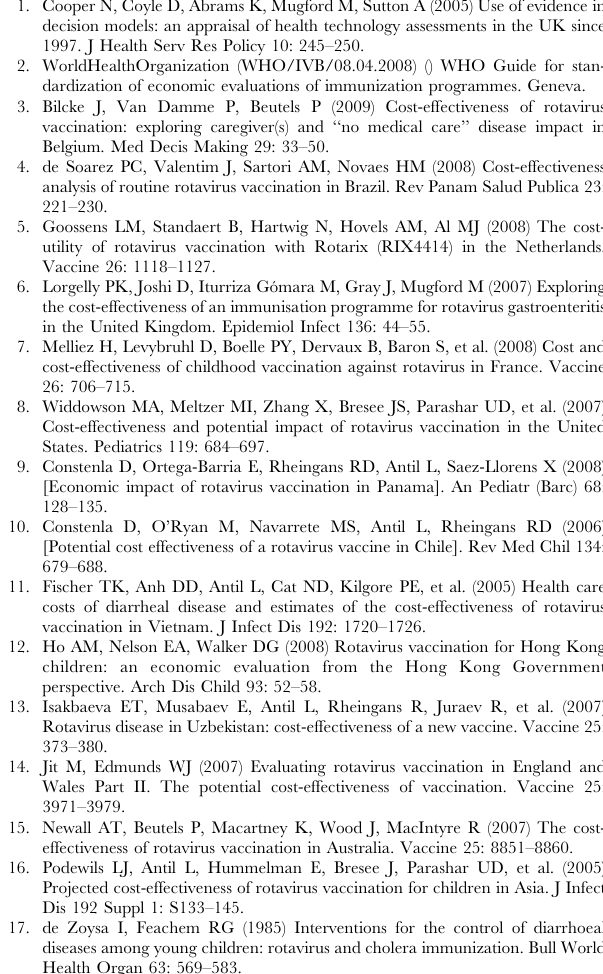
Table S3 Assessment of risk of bias in the reported outcomes of the 21 prospective studies included in the meta-analysis.